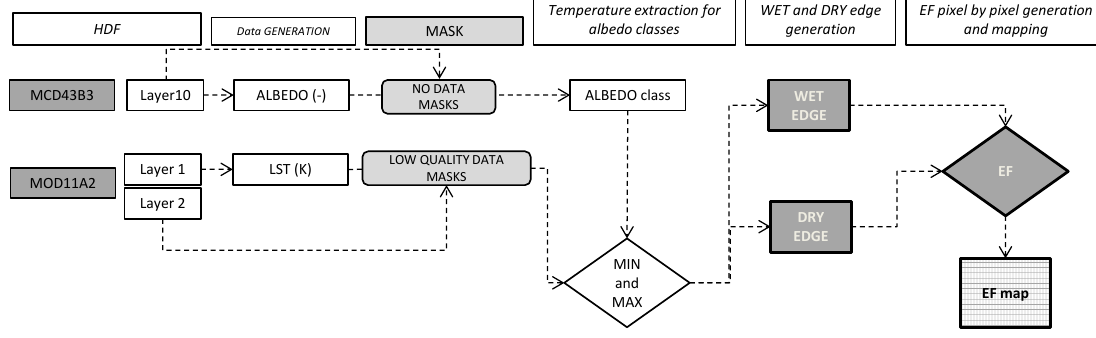
Figure 3. Flowchart for the evaporative fraction estimation from the MODIS products of albedo and land surface